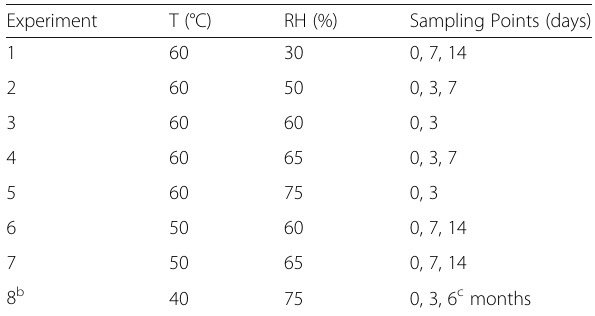
Table 1 a Temperature (T) and relative humidity (RH) conditions used in ASAP modeling